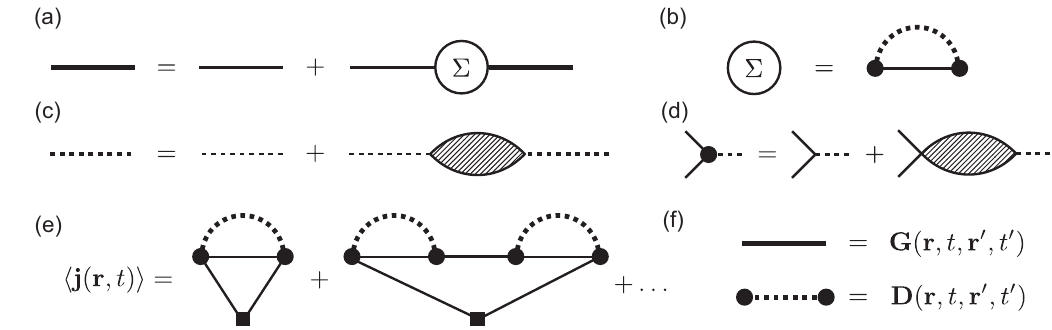
FIG. 2. Nonequilibrium diagrammatic expansion. (a) Dyson equation for the matrix Green ’ s function G (thick line). The thin line is the bare Green ’ s function G 0 . (b) First order self-energy diagram, which is computed for each of the electron-boson interactions. (c) Dyson equation for the random phase approximation (RPA) screening of the boson propagator (dashed line). (d) Dyson equation for the boson- electron vertex, within RPA. (e) Diagrammatic expansion for the electric current, which is related to the Keldysh Green ’ s function at equal point in space and time. The square represents a gradient operator (multiplication by q in momentum space). (f) Notation for the electron and boson Green ’ s functions. We have absorbed the RPA renormalization of the vertices into the definition of the bosonic